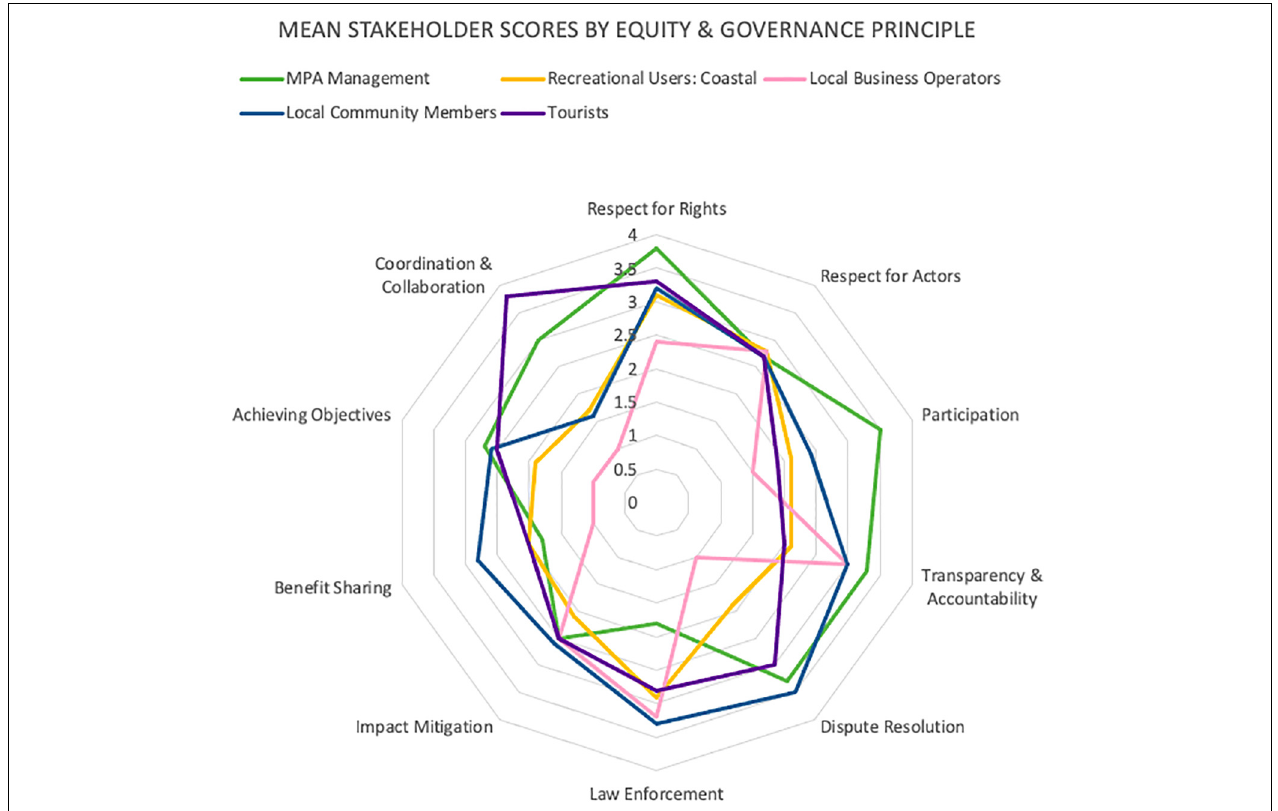
FIGURE 3 | Mean stakeholder scores by equity and governance principle for the Solway